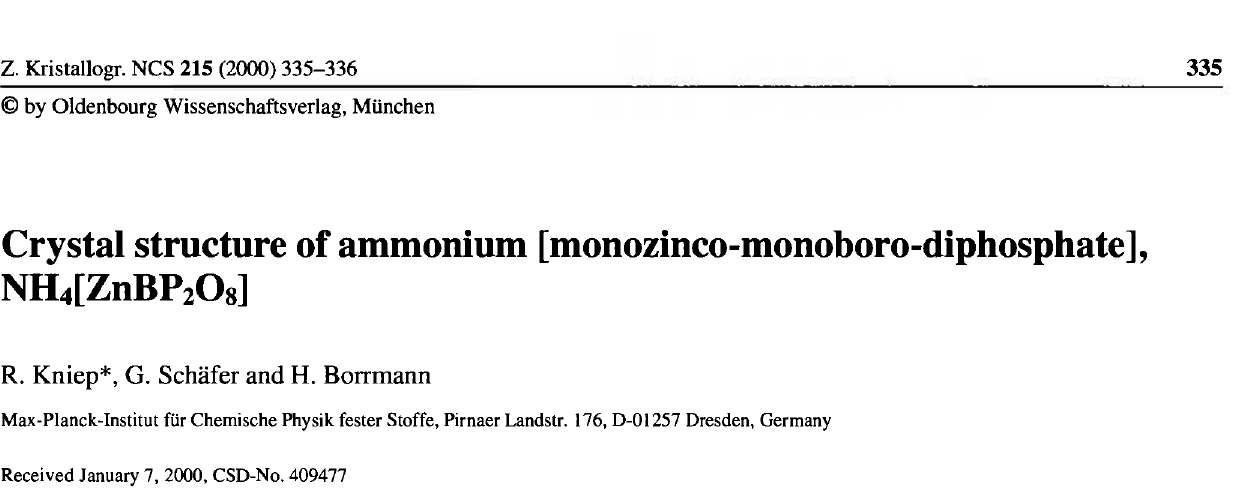
Table 1. Data collection and handling.